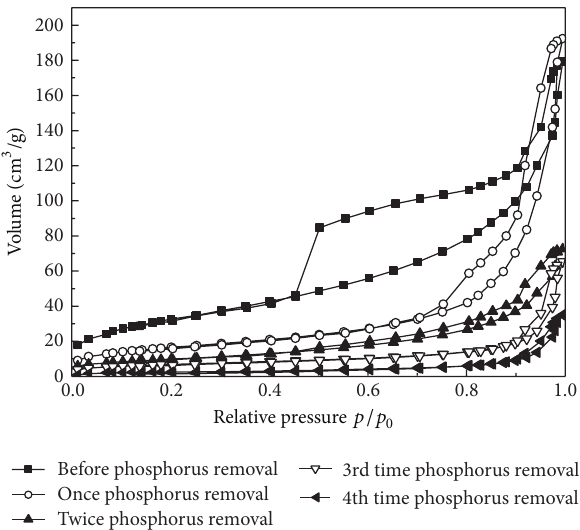
Figure 1: XRD patterns of samples.